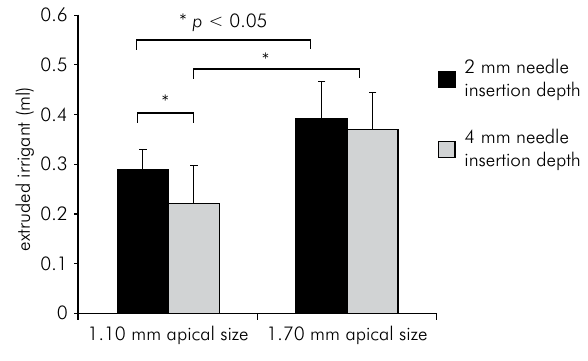
Figure 2. The glass vial